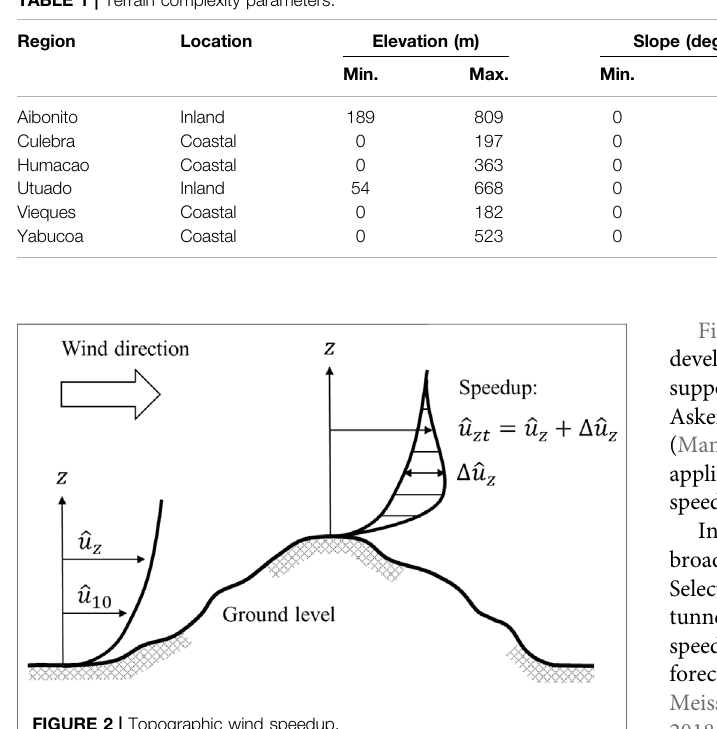
FIGURE 2 | Topographic wind